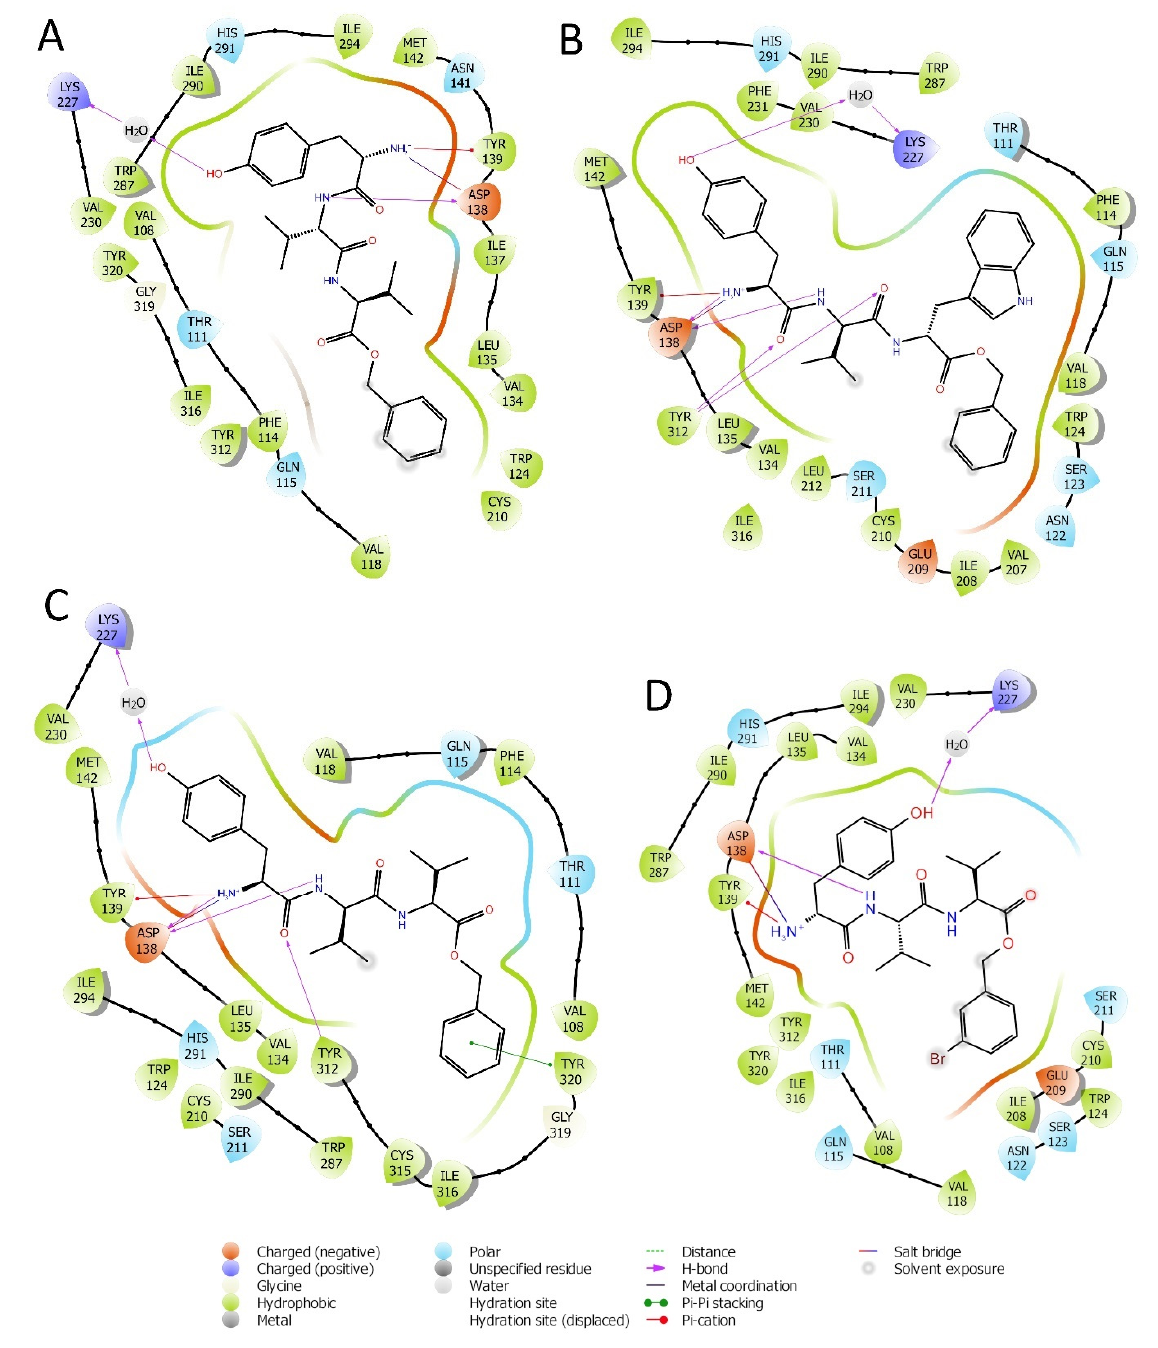
Figure 2. Interactions of peptides H-D-Tyr-Val-Val-OBz ( A ), H-D-Tyr-Val-Trp-OBz ( B ), H-D-Tyr-D-Val-Val-OBz ( C ), and H-D-Tyr-Val-Val-O-(3-Br)-Bz ( D ) with the amino acids residues of KOR binding site.